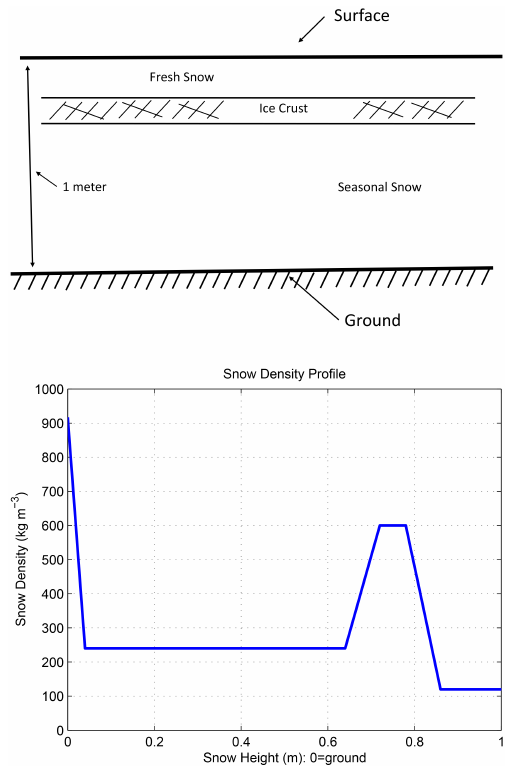
Figure 9. Snow cover characteristics and density profile for the macroscale heat and mass transfer numerical